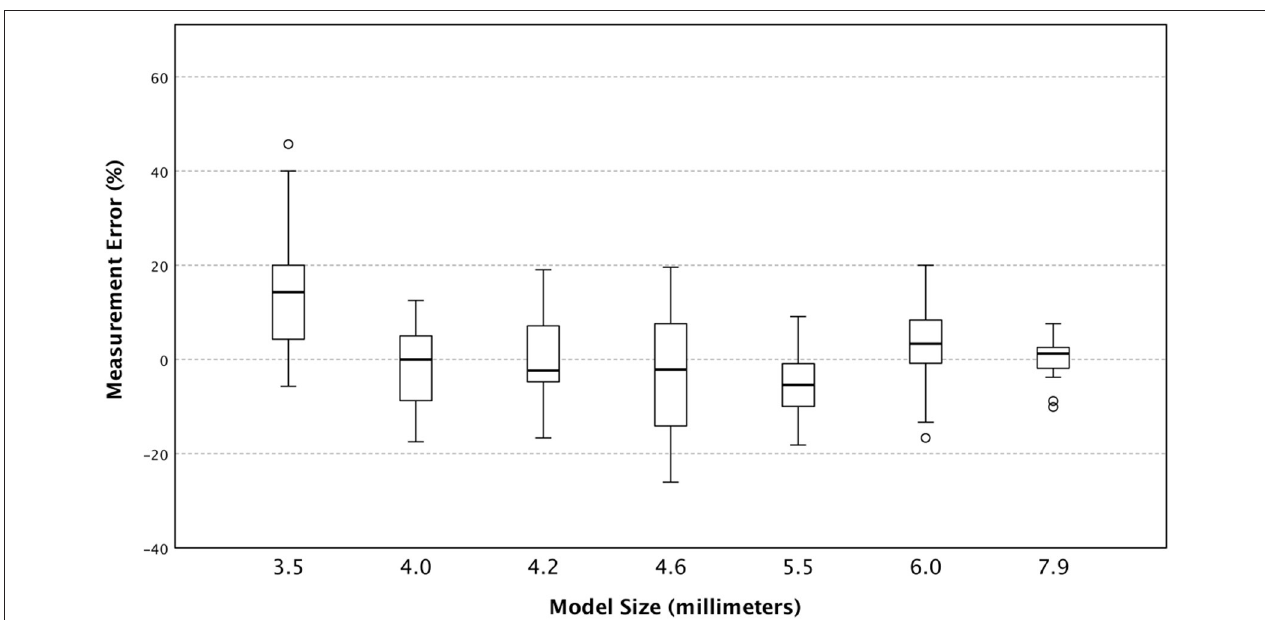
FIGURE 4 | The Box and whisker plot of percent measurement error (individual observed values minus predicted) stratified by predicted size of model optic nerve sheath